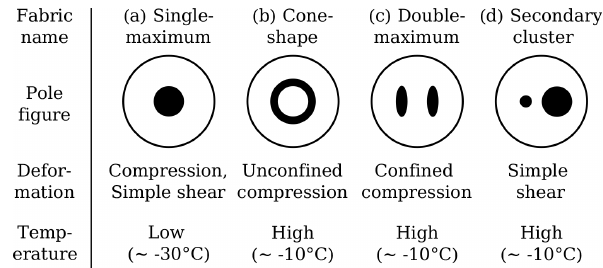
Figure 1. Illustration showing common fabrics or fabrics which de- velop in ice, illustrated by their pole figures, as well as the deforma- tion regime and temperature they typically occur at. The pole fig- ures show the distribution of c -axis orientations, with the compres- sion axis at the centre. Panel (a) shows a single-maximum fabric, produced in uniaxial compression or simple shear at low tempera- tures (Qi et al., 2019). Panel (b) shows a girdle fabric, produced in uniaxial compression at higher temperatures, when grain boundary migration is active (Paterson, 1999). This can also be considered a girdle fabric when the cone angle approaches 90 ◦ . (c) shows a double-maximum fabric produced in pure shear (Budd et al., 2013). (d) shows a single maximum with a secondary cluster, produced in simple shear at higher temperatures (Kamb, 1972; Qi et al., 2019). Note: this simple shear deformation is rotated 45 ◦ to keep the prin- cipal deformation axes constant relative to the other